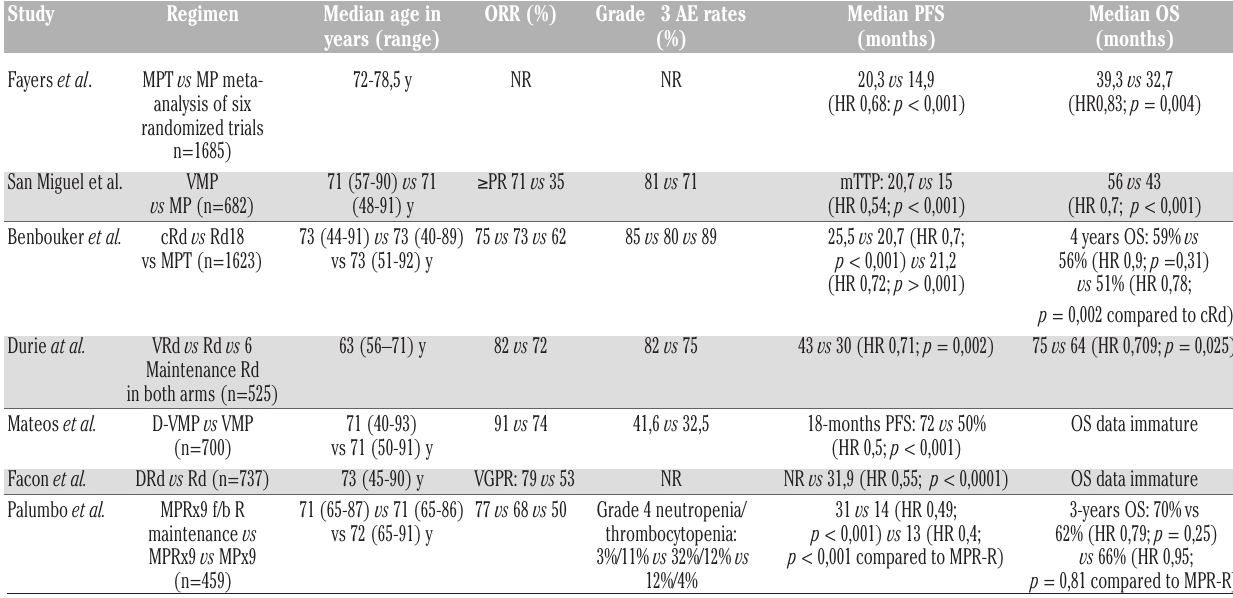
Table 1. Selected regimens in newly diagnosed transplant-ineligible multiple myeloma.